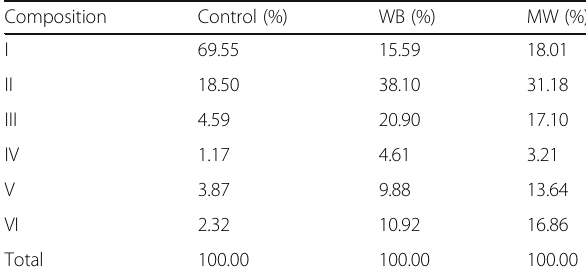
Table 1 The content of each component in 0% basicity chromium sulphate tanning liquor warmed under different